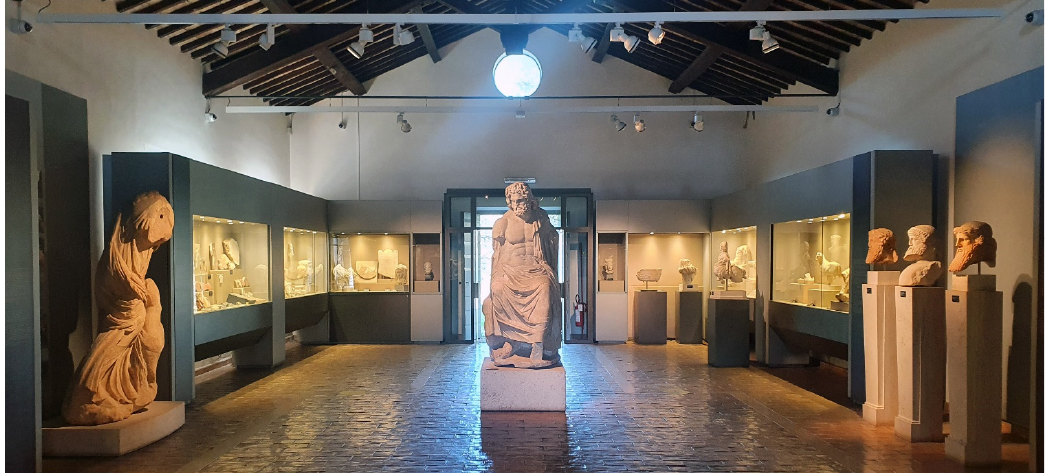
Figure 4. Internal view of Antiquarium di Villa dei Quintili. Source: MuseoItalia [78].